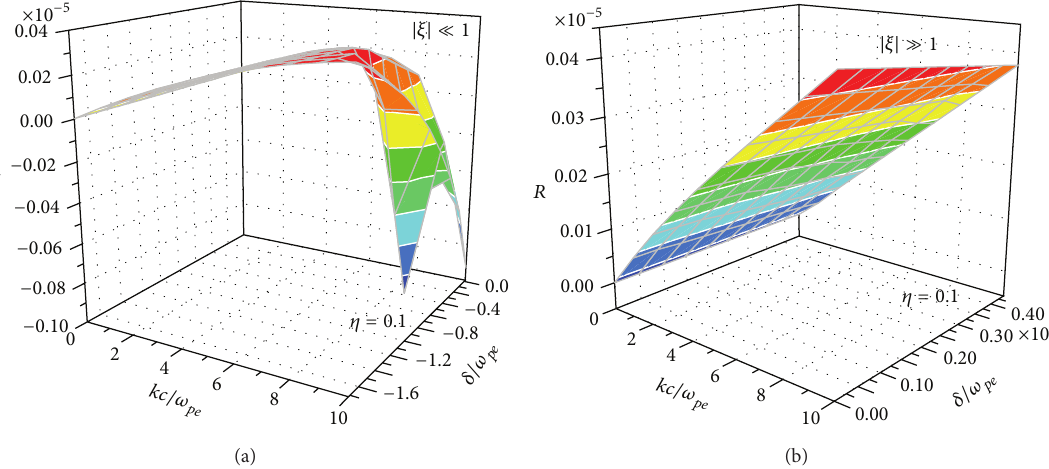
Figure 4: The growth rate of the Weibel instability, 𝛿/𝜔 𝑝𝑒 , as a function of wavenumber, 𝑘𝑐/𝜔 𝑝𝑒 , and quantum parameter, 𝑅 , for the fixed density gradient, 𝜂 , (a) for the small wavelengths, (b) for the large wavelengths.